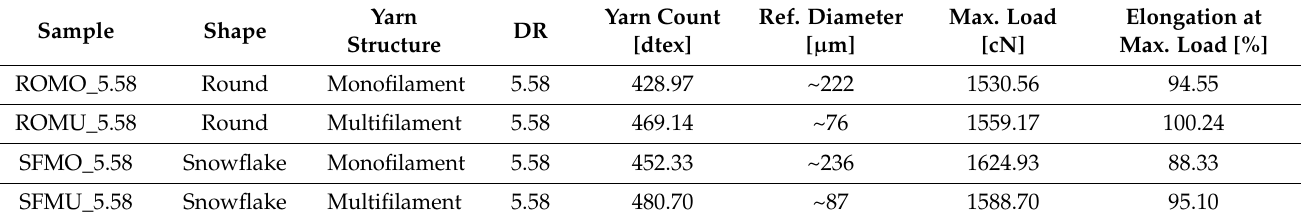
Table 1. Overview of fibers used for exposure to PBS at 37 ◦